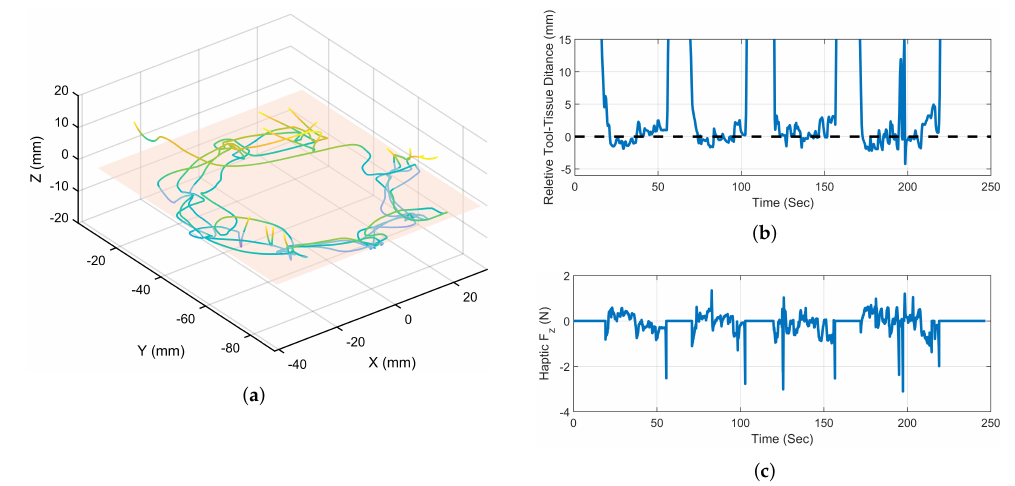
Figure 9. Needle insertion task results for hyperplanar VF assistance mode. ( a ) 3D path of the needle tip in space toward the desired entrance point; ( b ) relative position of the end-effector centre of rotation above the VF plane; ( c ) user received force F h